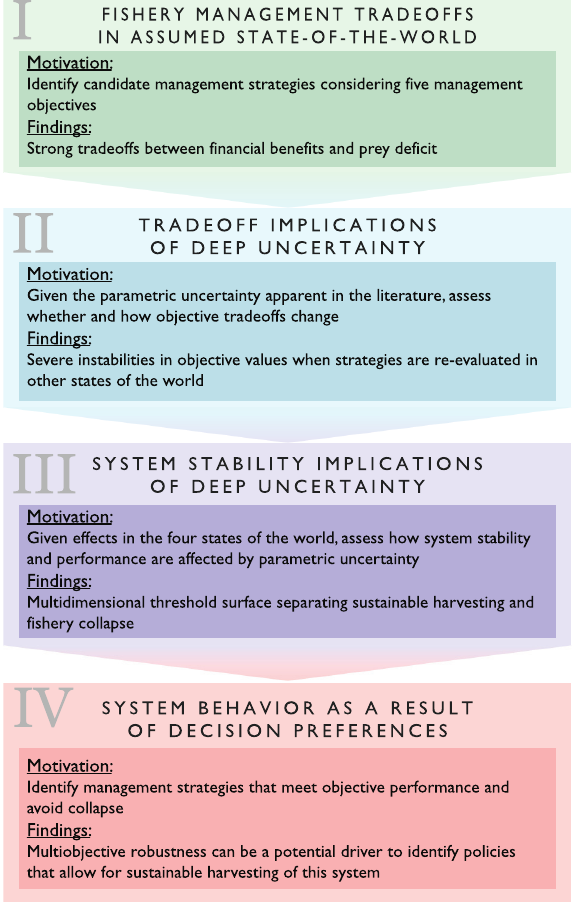
Figure 2: Main findings on the implications of deep uncertainty on this predator-prey system. Latin numerals indicate the Results and Discussion sections in which each step is presented. See the main text for further